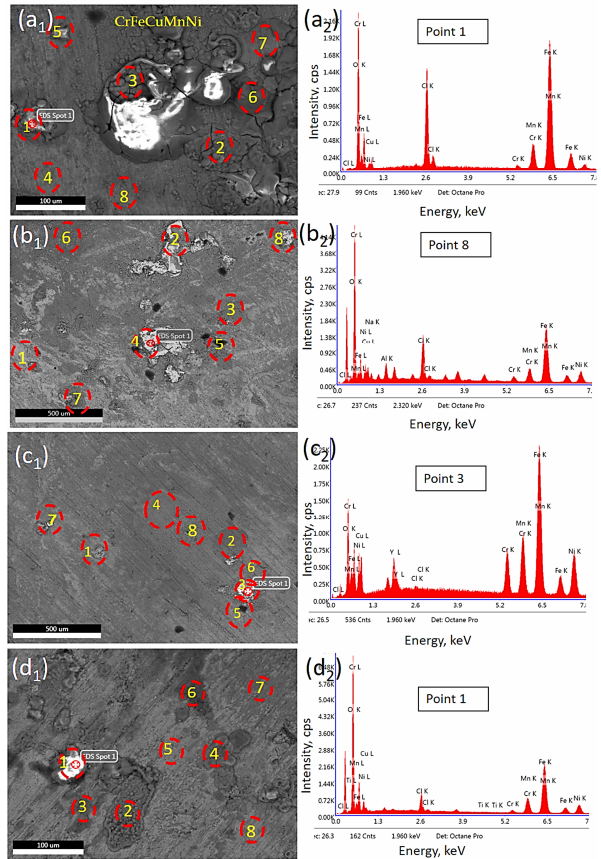
Figure 17 . HRSEM surface morphology of corrosion products with EDS point analyses ( left ) and the corresponding EDS spectrum of the selected one as an example ( right ): ( a 1 , a 2 ) CrFeCuMnNi; ( b 1 , b 2 ) CrFeCuMnNi-3 vol.% Al 2 O 3 ; ( c 1 , c 2 ) CrFeCuMnNi-3 vol. % Y 2 O 3 ; and ( d 1 , d 2 ) CrFeCuMnNi-3 vol.% TiO 2 . (The numbers 1 to 8 indicates the EDS point analyses taken on the spot)